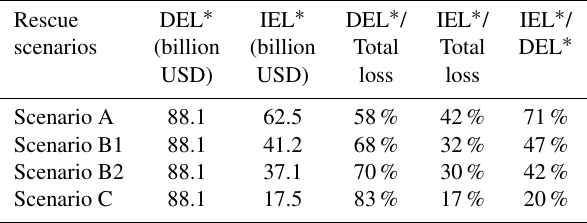
Table 3. Evaluation results of the indirect economic loss of Bei- jing (BJ) under different rescue